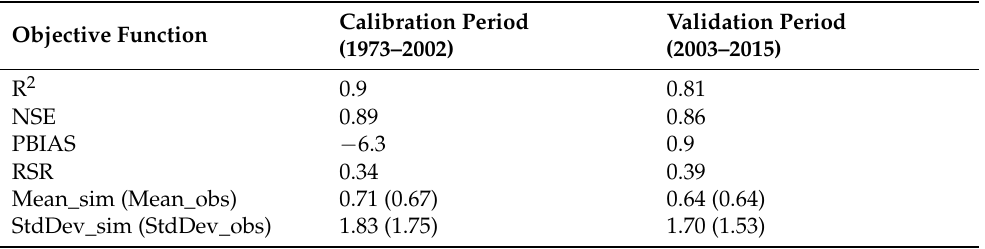
Table 4. Summary statistics of the objective functions for the calibration and validation periods.